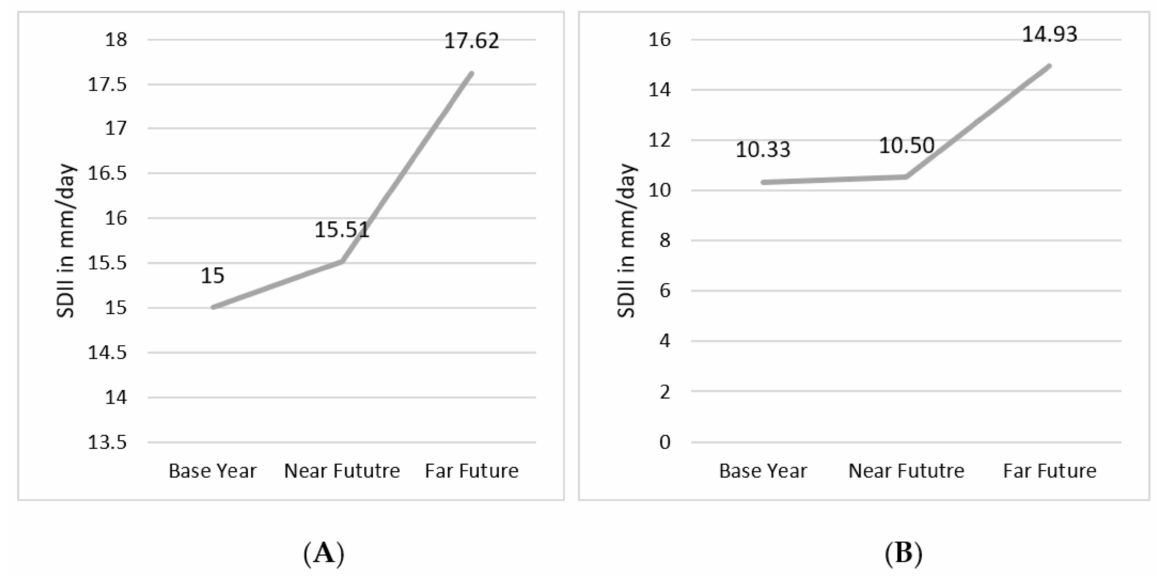
Figure 11. SDII for June–September ( A ) from BCC-CSM2-MR model and ( B ) from MRI-ESM2-0